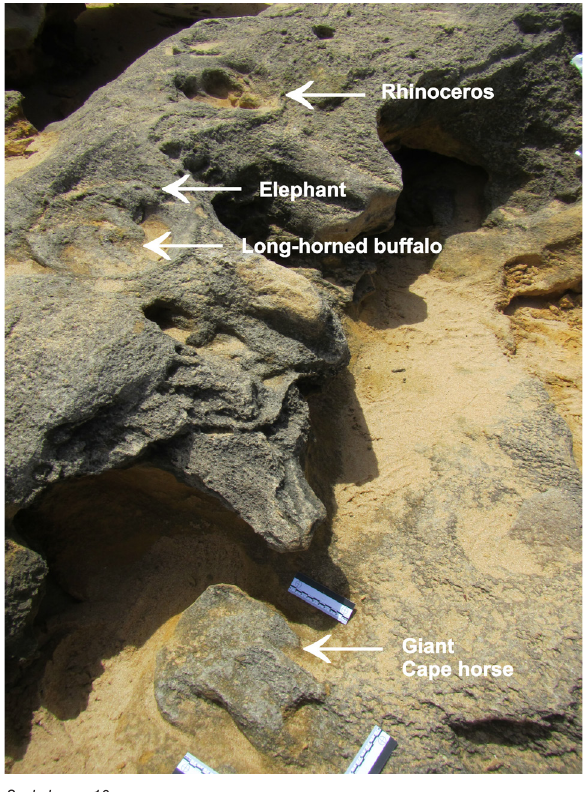
Figure 7: Upper surface of Megafauna Rock; arrows indicate tracks.